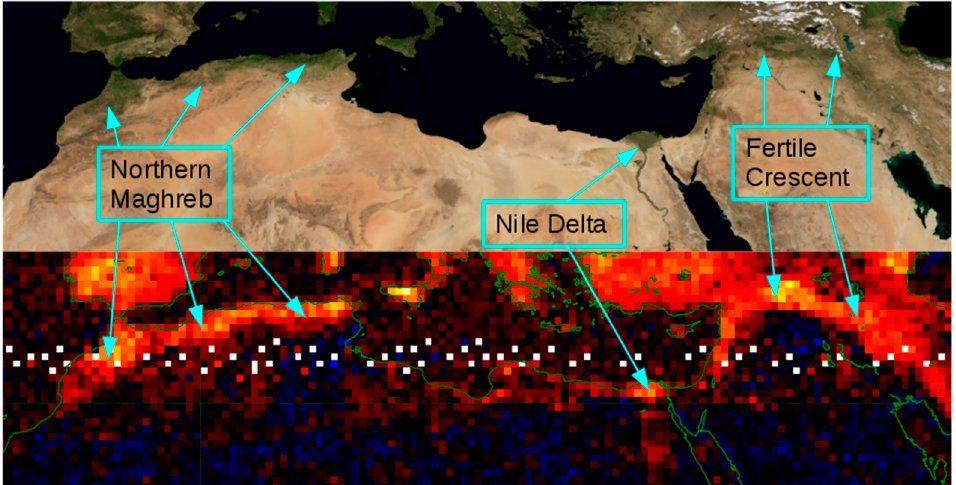
Figure 3. Example of the spatial pattern of SiF retrieved over North Africa and the Middle East for April 2013 (lower panel). A true colour image for the same geographical region is shown for comparison (upper panel). The white colour indicates grid boxes without data points. The regular pattern of missing data points is caused by a specific sequence of GOME-2 instrument modes around that time.